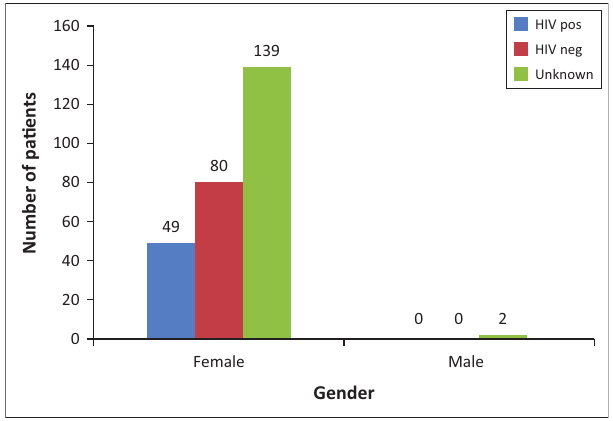
FIGURE 1: Depiction of human immunodeficiency virus status according to gender.